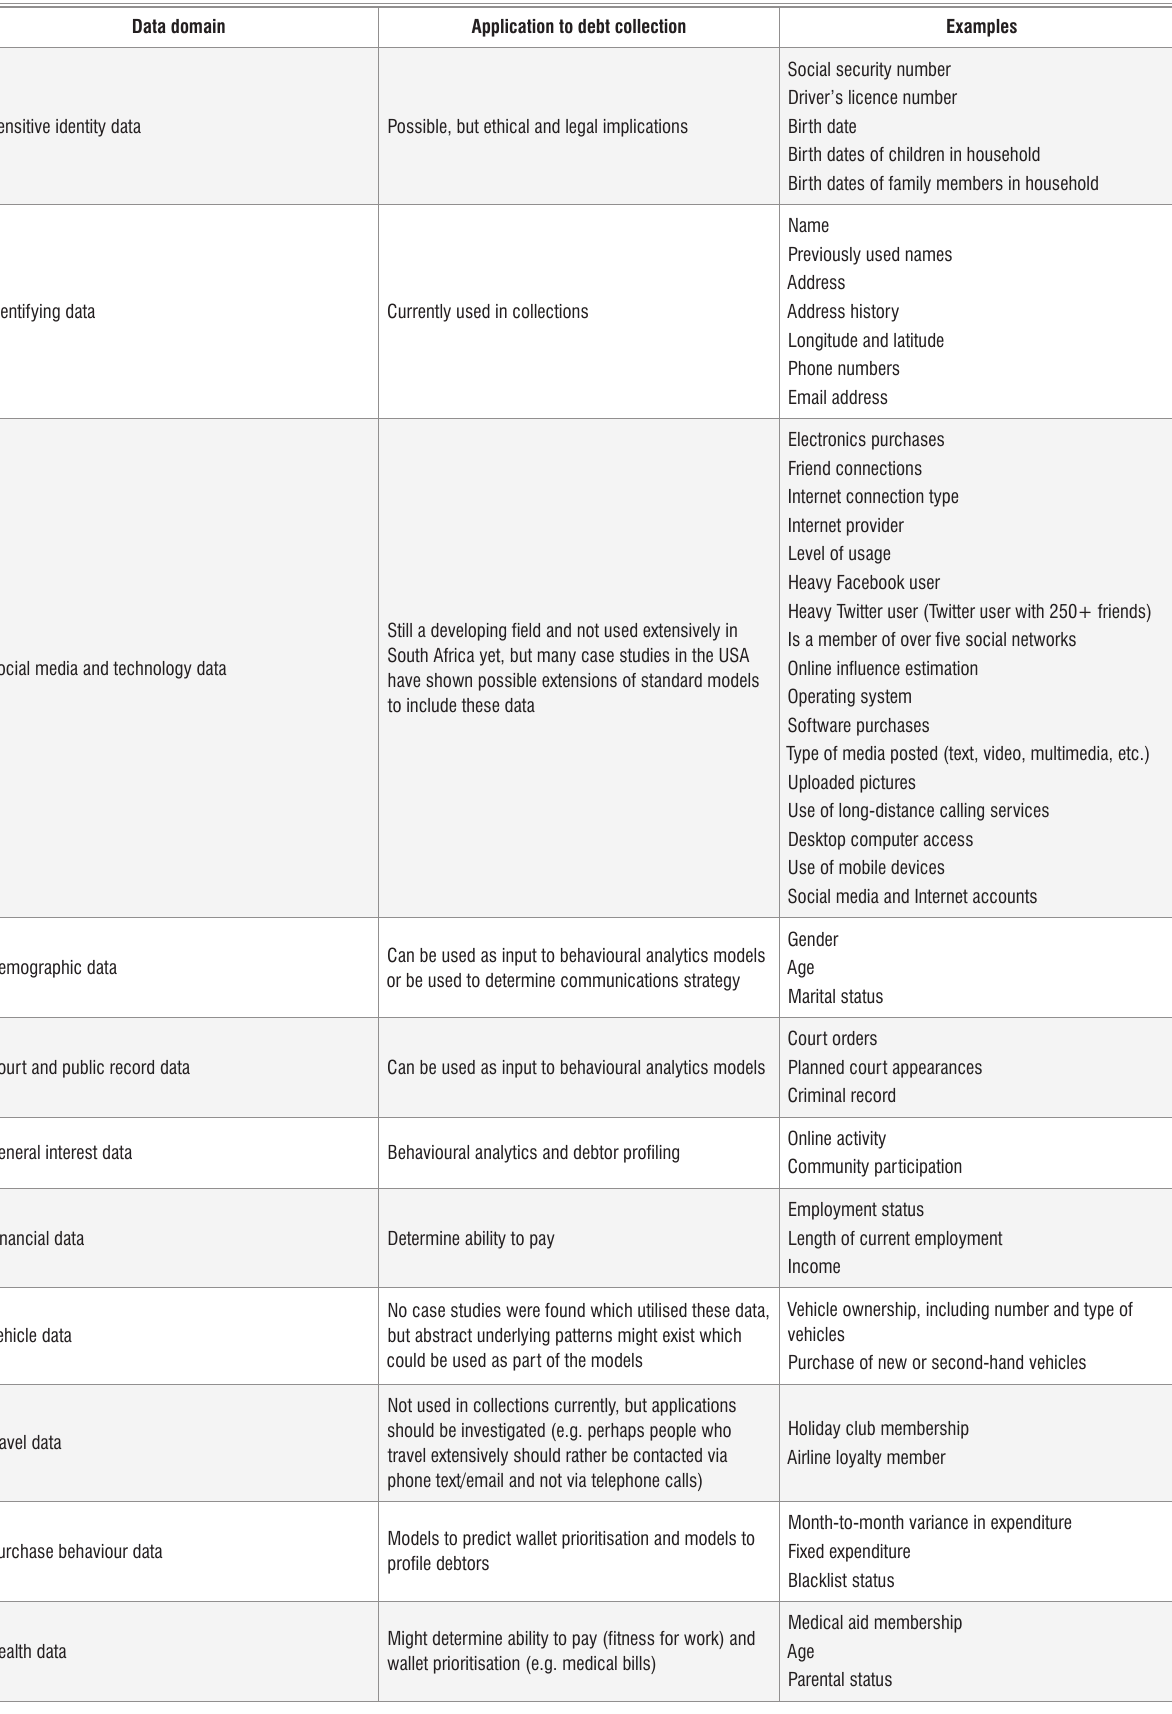
Table 3: Overview of data provided by data